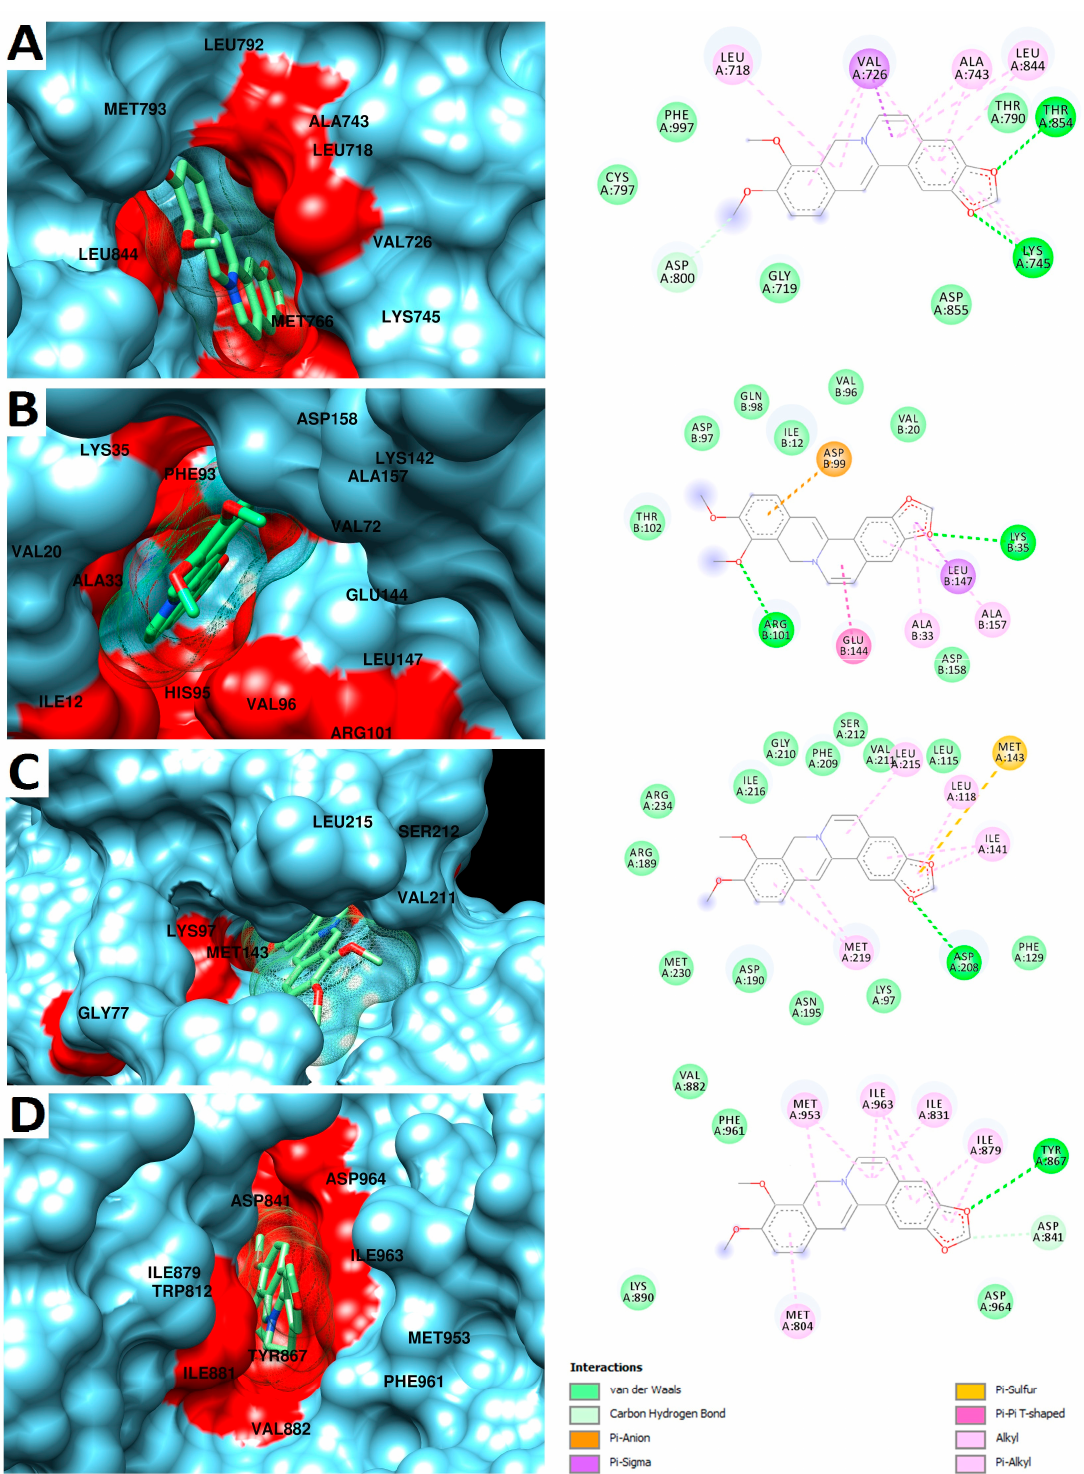
Figure 1. Molecular surface representation of human epidermal growth factor receptor-2 (HER2) ( A ), cyclin-dependent kinase 4 (CDK4) ( B ), mitogen-activated protein kinase kinase (MEK) ( C ), and phosphoinositide 3-kinase (PI3K) ( D ) on the left, while the detailed 2D interactions are illustrated on the right. Berberine with the best docked pose is highlighted in sticks with mesh surface representation inside the binding pocket.